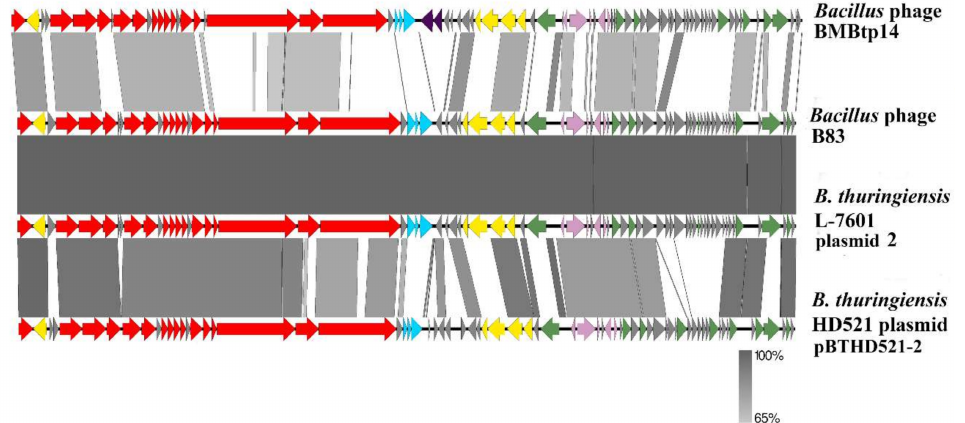
Figure 4. The BLASTN comparison of the B83 genome and the related genomes visualized with Easyfig. Red arrows – ORFs with predicted morphogenesis functions, cyan arrows – lytic functions, yellow arrows – prophage maintenance, pink arrows – lysis-lysogeny switch, green arrows – DNA replication, recombination, and modification. Dark purple arrows in the BMBtp14 genome indicate the genes absent in the other three genomes, which are probably associated with the mobile genetic element. Gray arrows indicate ORFs with unknown functions. Gray regions between the genome maps indicate the level of identity (see the